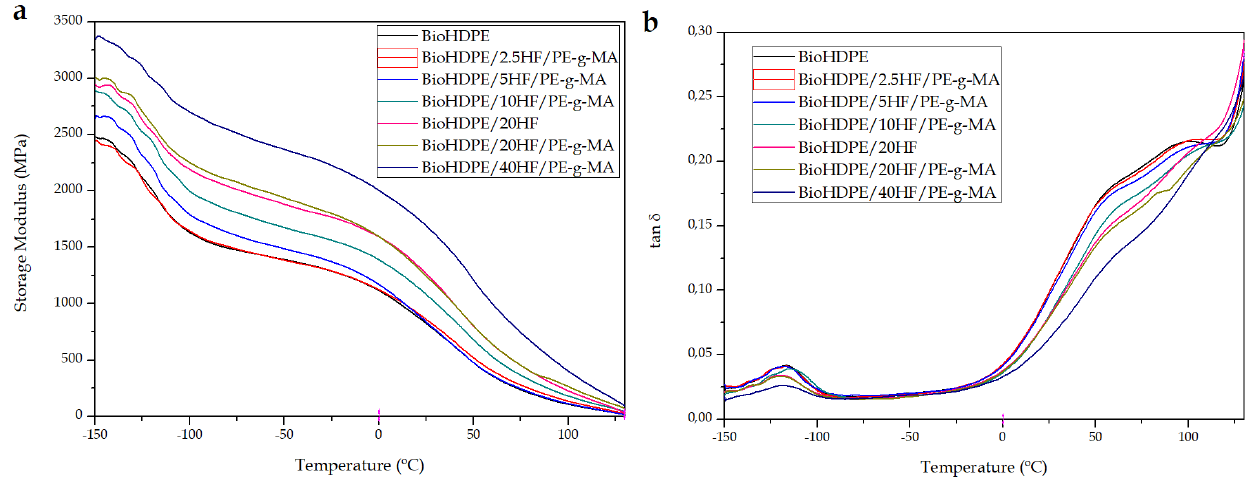
Figure 7. Thermomechanical properties of Bio-HDPE/Hemp fibers composites as a function of temperature: ( a ) storage modulus (E’) and ( b ) dynamic damping factor (tan δ ).